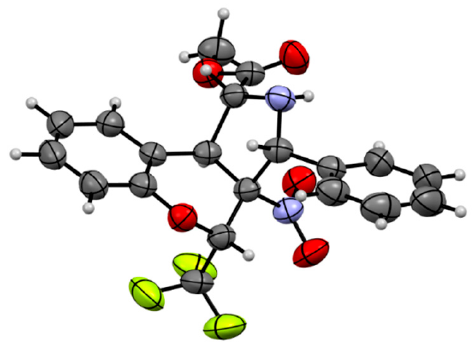
Figure 5. Molecular structure of endo - 9a (ORTEP drawing, 50% probability level). In the 1 H NMR spectra of 2-CCl 3 -substituted chromanes 10a − g , the signals of the H-2 ’ , H-3 ’ and H-4 ’ protons of the chromane ring in the range of 5.18–5.30, 6.25–6.29 and